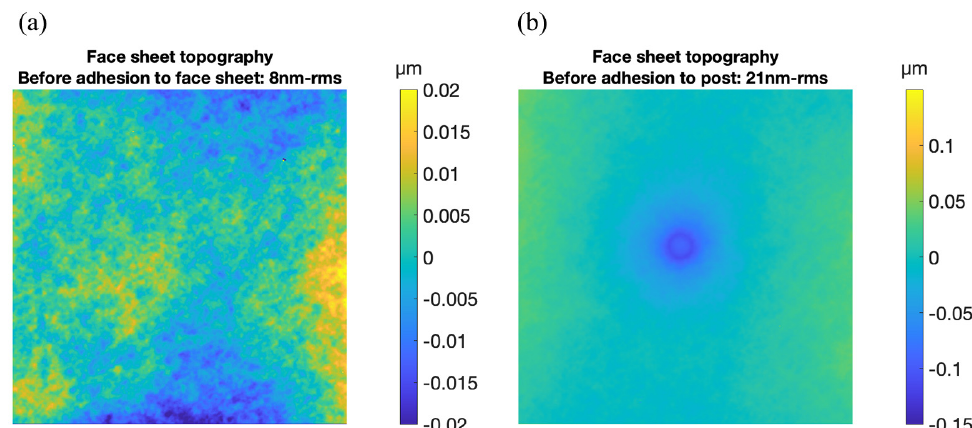
Figure 5. Surface topography maps of two regions of the test structure face sheet before adhesive a tt achment of magnets to face sheet or post. ( a ) In a 1.54 mm square region away from the area of post a tt achment, the root-mean-square deviation from fl atness was 8 nm-rms. ( b ) In a 1.54 mm square region directly above the post a tt achment, some deformation of the face sheet due to the 300 µm diameter post a tt achment was evident. Root-mean-square deviation from fl atness was 21 nm- rms.